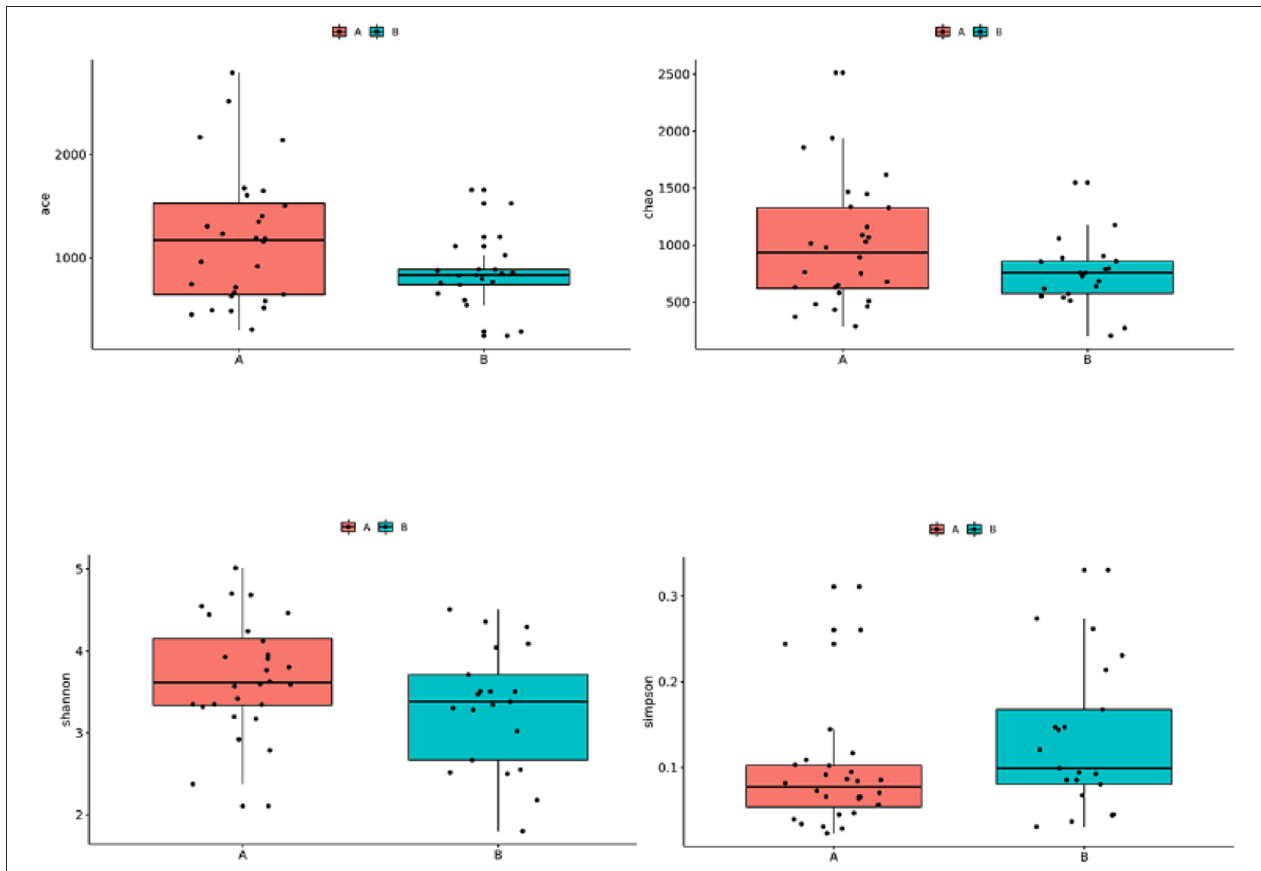
FIGURE 1 | Comparison of the alpha diversity of gut microbiota in children with TD and control children. Group A: TD group; Group B: control group.